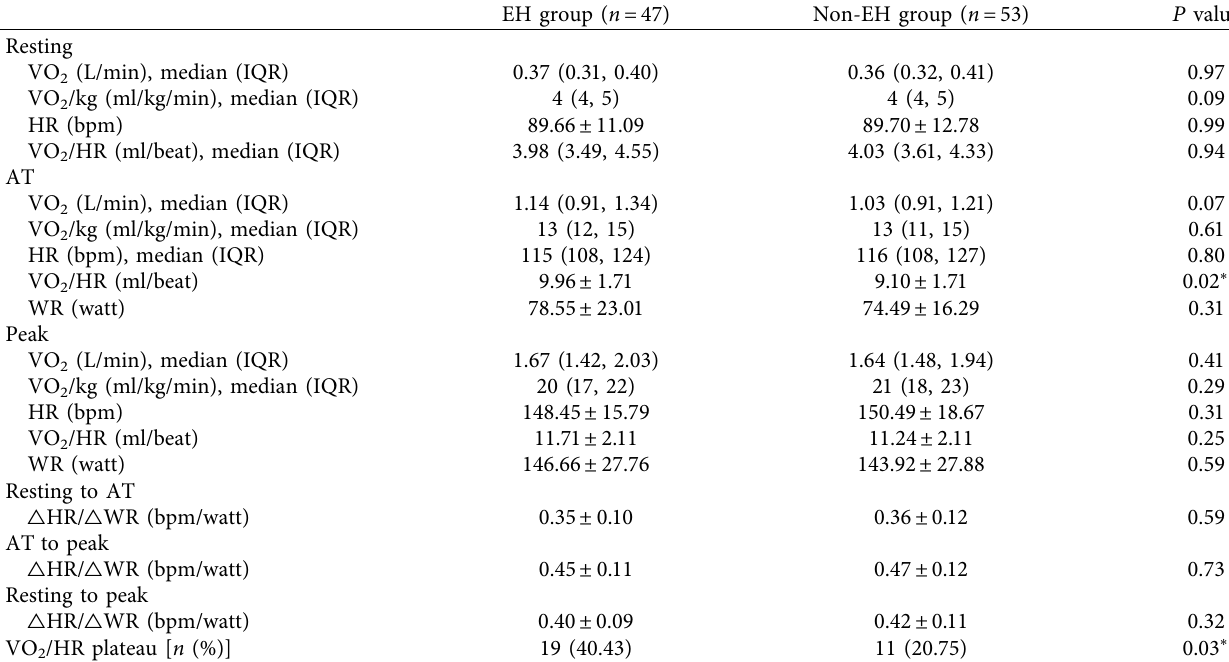
Table 2: Comparison of CPET parameters between EH group and non-EH group.